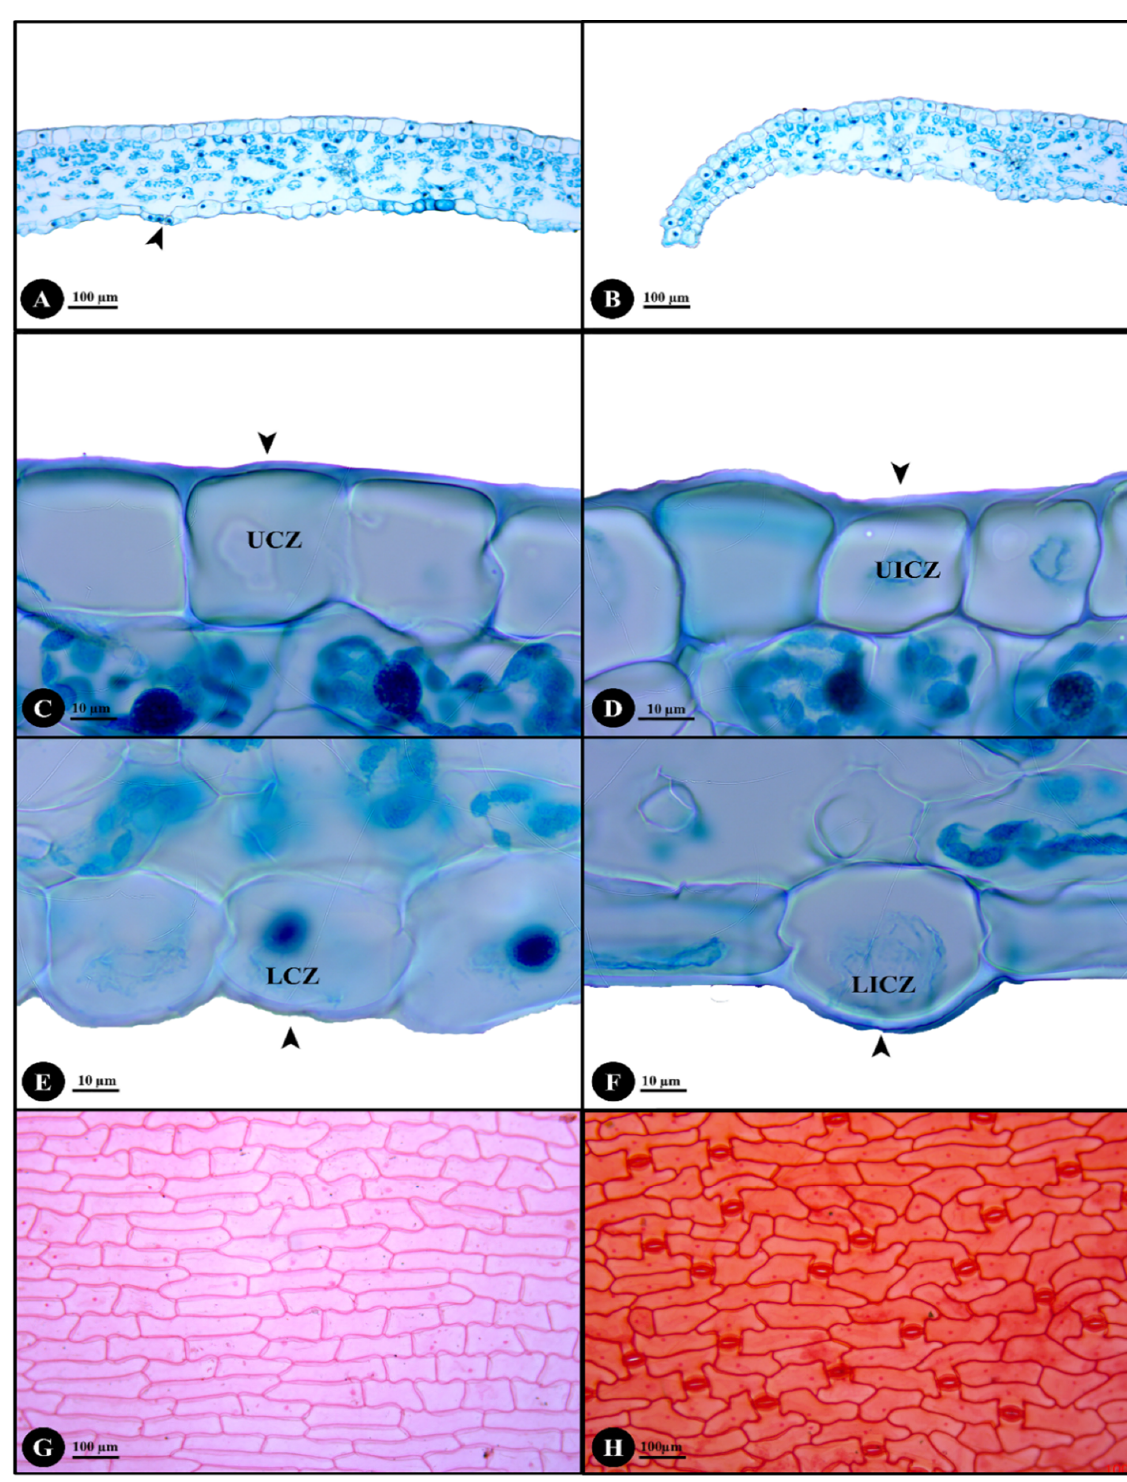
Figure 3. Leaf anatomical characters of Disporopsis longifolia . ( A ) Raised stomata (arrowheads); ( B ) revolute margin; ( C ) smooth cuticle thickening (arrowhead) of upper epidermis at coastal zone; ( D ) smooth cuticle thickening (arrowhead) of upper epidermis at intercostal zone; ( E ) smooth cuticle thickening (arrowhead) of lower epidermis at coastal zone; ( F ) smooth cuticle thickening (arrowhead) of lower epidermis at intercostal zone; ( G ) upper epidermis surface; ( H ) lower epidermis surface; abbreviations: UCZ, upper epidermis in coastal zone; UICZ lower epidermis in coastal zone; LCZ, lower epidermis in coastal zone; LICZ, lower epidermis in intercostal zone.